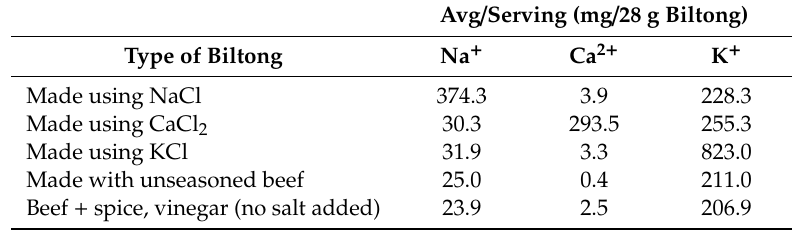
Figure 7. Comparison of reported Na + content (per serving size) to the calculated Na + content of two commercial biltong products (Product 1, 2) for each of two companies (Company A, B). Reported values were obtained from product labels; calculated values were based on triplicate replication of Na + analyses using the method described herein. Products were obtained locally from supermarkets. Table 2. Salt ion concentration of biltong beef produced during this study based on a comparable 28 g (1 oz) serving